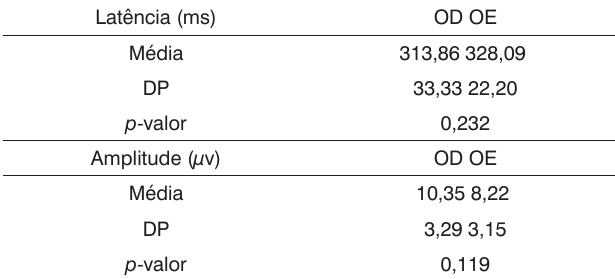
Tabela 4. Média e Desvio Padrão (DP) referente às latências e amplitudes do P300 para estímulo verbal, orelhas direita e esquerda agrupadas (n =